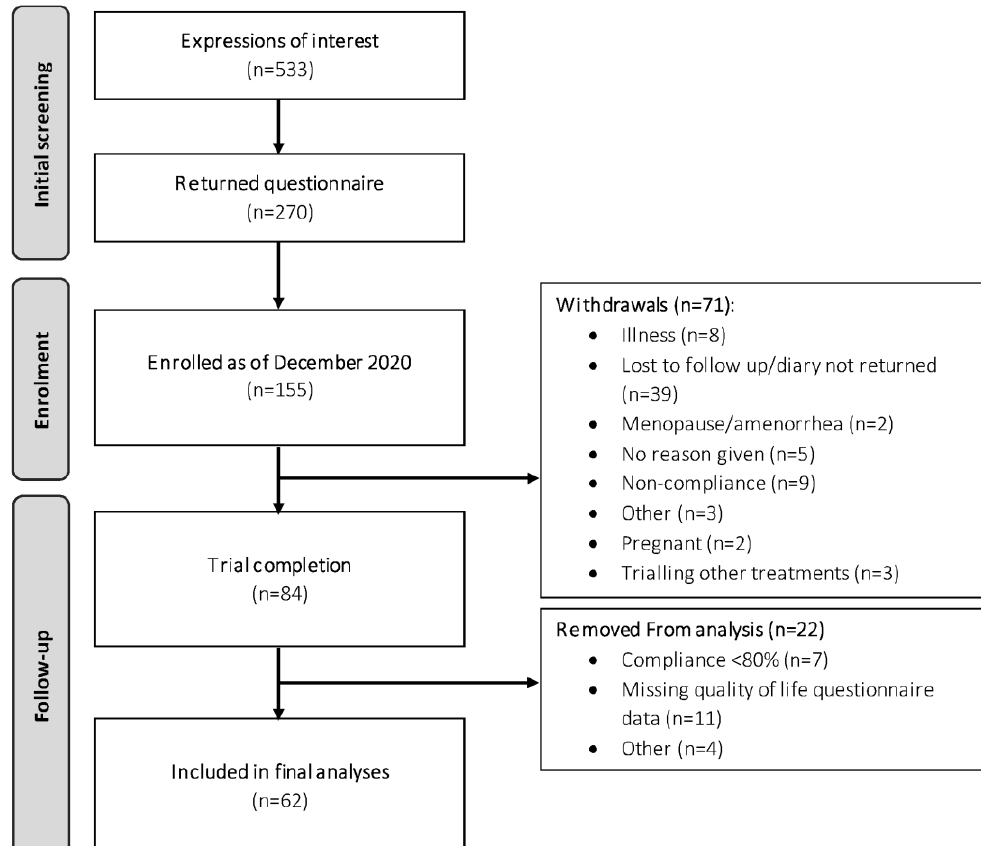
Figure 1. CONSORT diagram depicting flow of study participants. Table 1. Participant Characteristics.